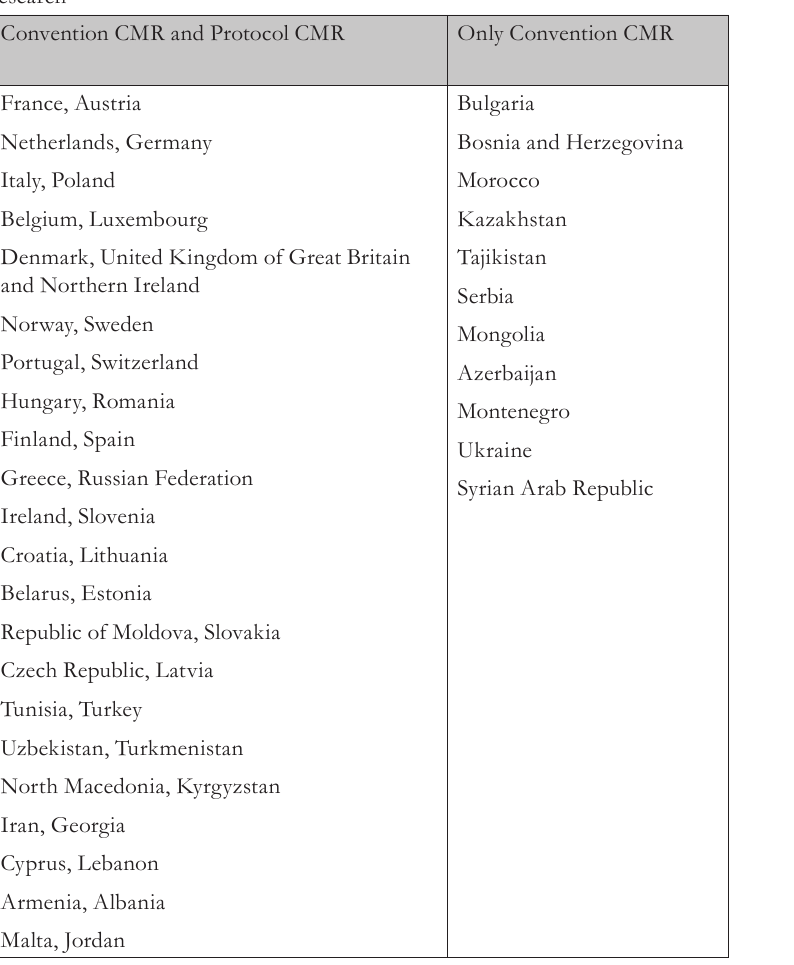
Tab. 1 – Contracting parties of the CMR Convention and the Protocol CMR. Source: